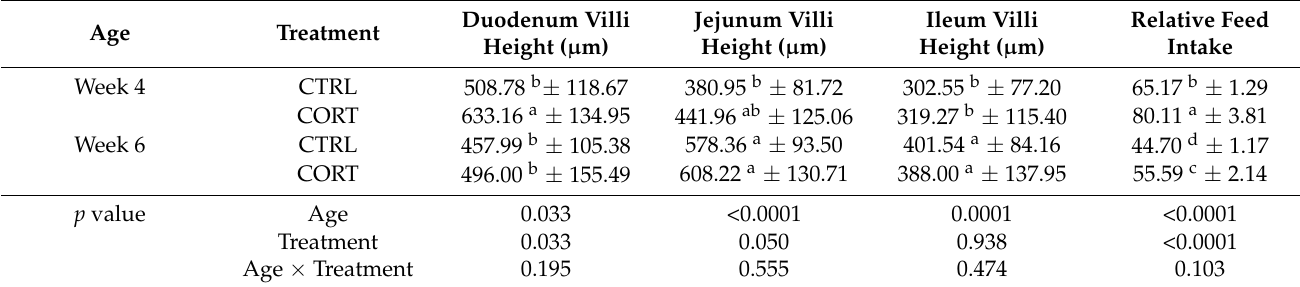
Table 4. Effect of corticosterone administration and age on duodenum, jejunum, and ileum villi heights ( ± SD) of broiler